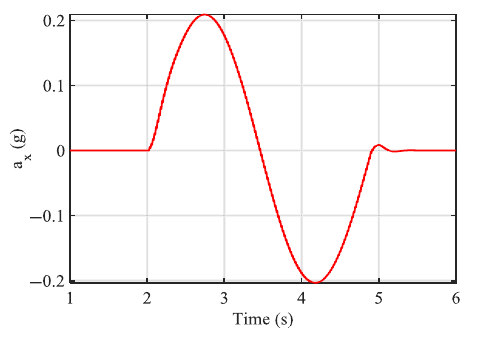
Figure 14 The torque inputs in Dynamic Figure 17 The lateral acceleration